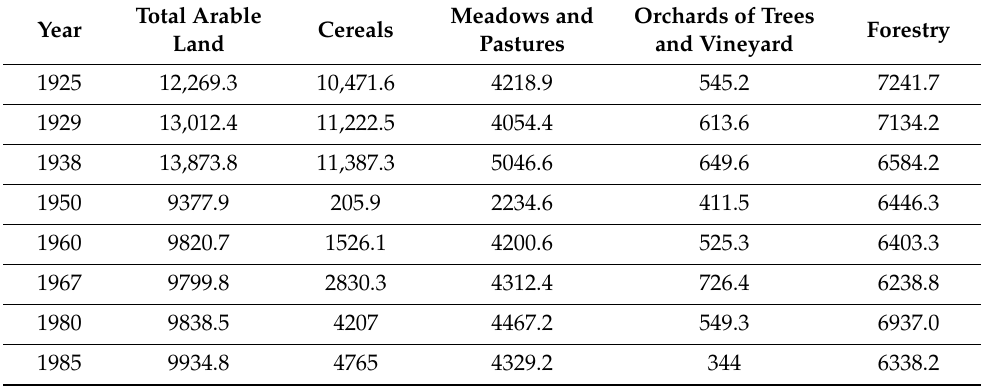
Table 2. The evolution of the number of hectares according to culture 1925–1984 (million